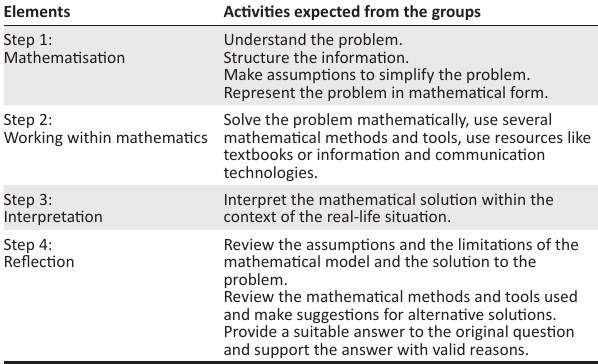
FIGURE 3 : Real-world data from the ‘ Location Problem ’ to inform a recommendation on the best location for a day-care centre for TABLE 1 : Elements of the predesigned worksheet: Four-step plan.